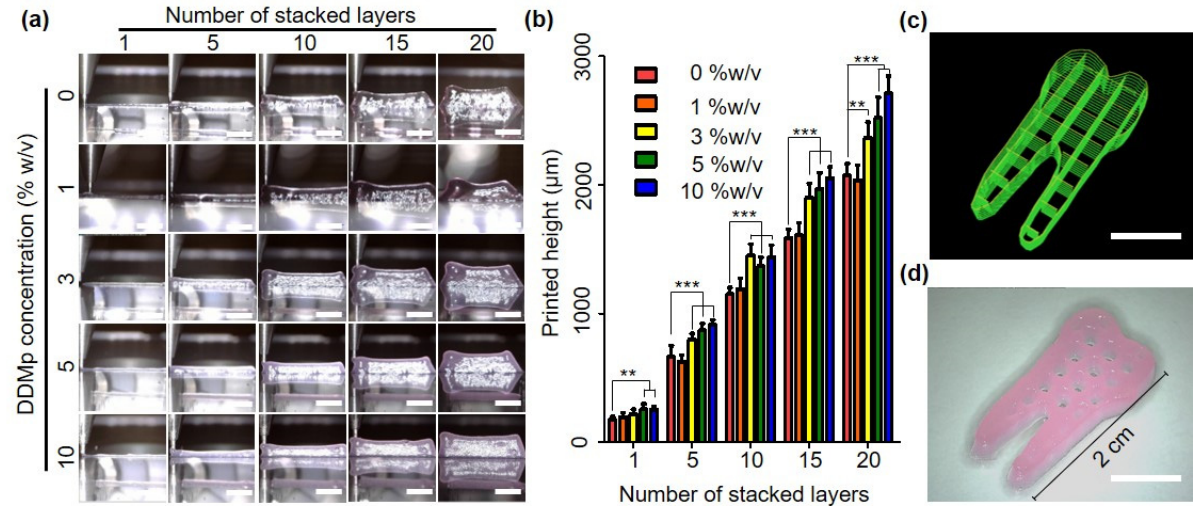
Figure 6. Stacking test of DDMp bio-inks. Microscopy images (scale bar: 5 mm) ( a ) and measured heights ( b ) of multilayered structures printed with DDMp bio-inks in the change of the number of stacked layers ( n = 6), ( c ) visualized printing code and ( d ) fabrication result of tooth-shaped hydrogel construct printed with DPSC-laden DDMp bio-ink (10% w / v ) (scale bar: 10 mm). The visualized code indicates the printing paths to produce the designed 3D structure. ** p < 0.01; *** p < 0.001.